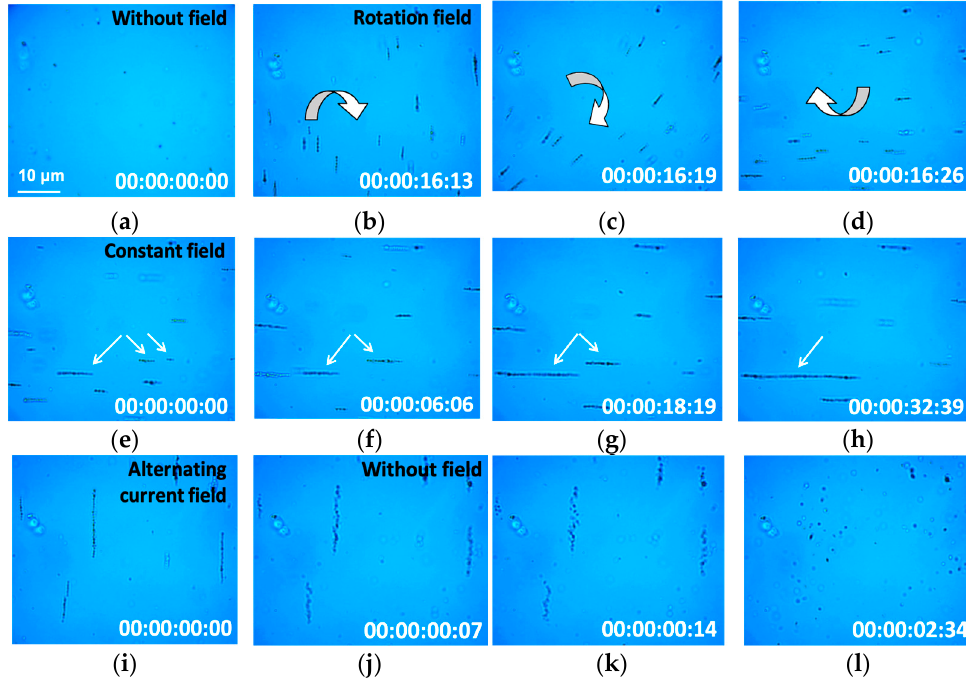
Figure 2. Magnetite–gold dumbbell nanoparticle behavior under low-frequency magnetic field in water solution. ( a ) MNPs before magnetic field exposure; ( b – d ) MNPs in rotation field (1 Hz, 7 mT); ( e – h ) MNPs in the constant field (7 mT); ( i ) MNPs in alternating current field (1 Hz, 7 mT); ( j – l ) MNPs after alternating current field termination.